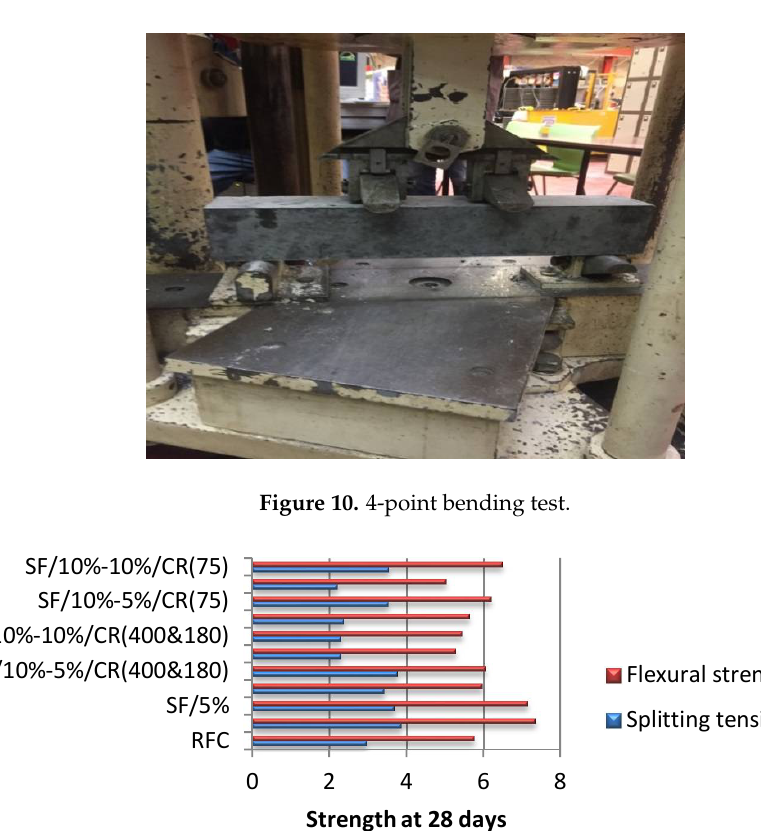
Figure 9. Splitting tensile test.